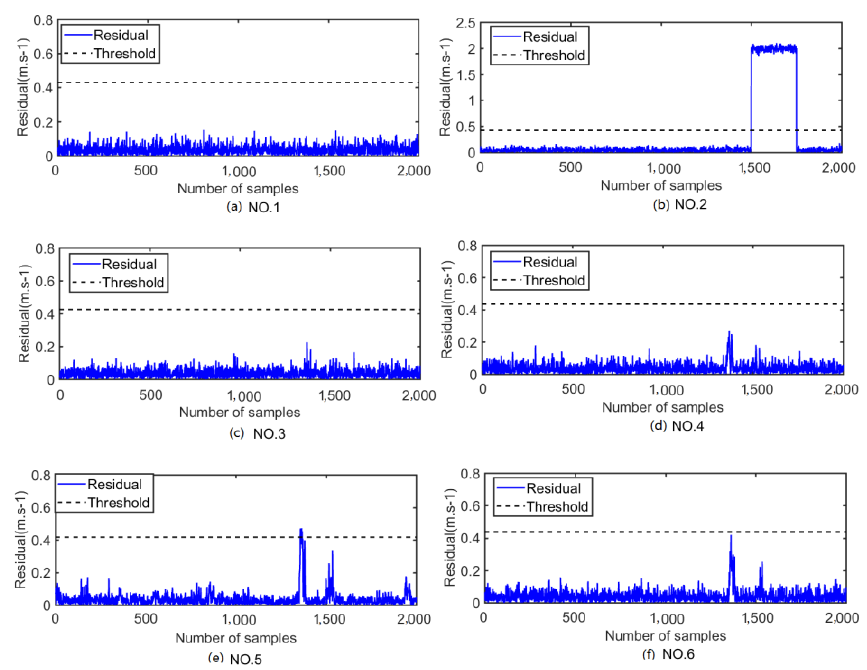
Figure 3. Single fixed deviation fault status of the six anemometers:( a ) Residual curve of WTG 1; ( b ) Residual curve of WTG 2 ( c ) Residual curve of WTG 3 ( d ) Residual curve of WTG 4 ( e ) Residual curve of WTG 5 ( f ) Residual curve of WTG 6.